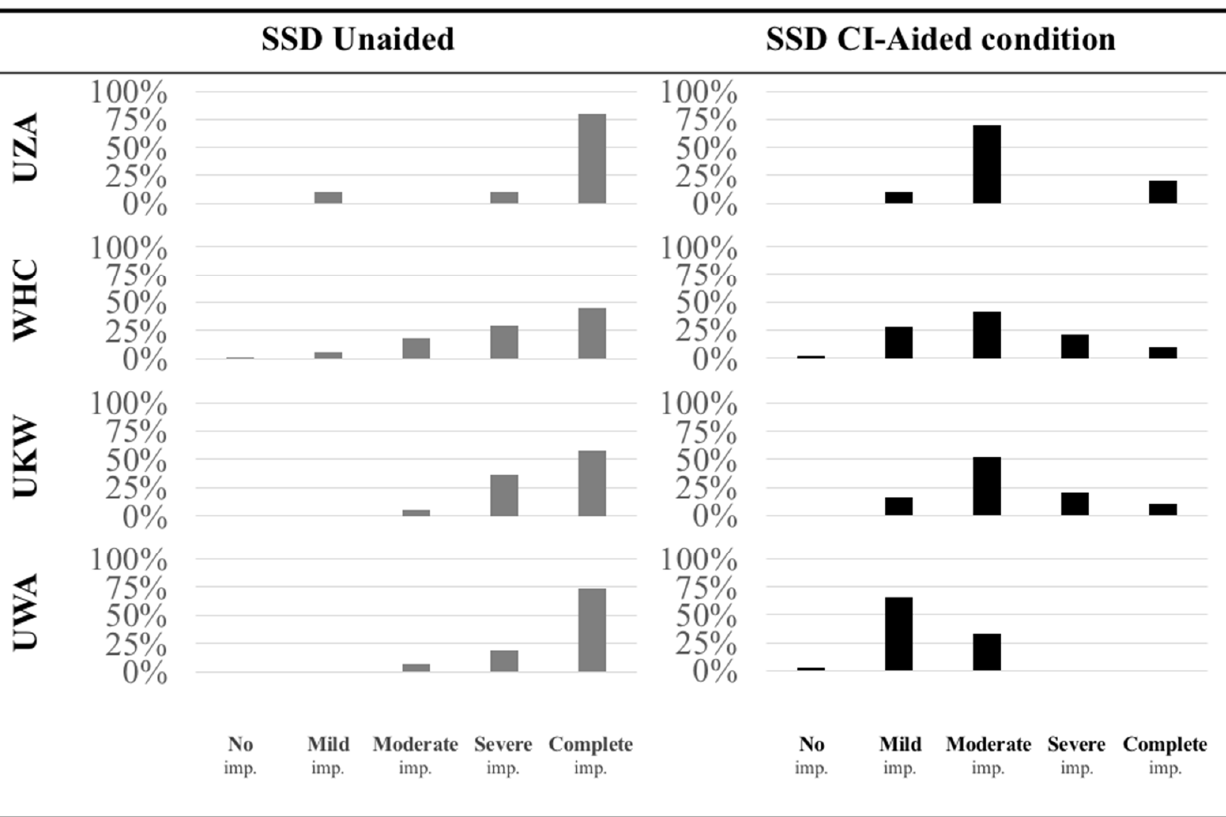
Figure 3. Application of the HEARRING_LOC_ICF scale on SSD CI data from the Antwerp University Hospital (UZA) in Belgium, for the World Hearing Center (WHC) in Poland, for the University Clinic of Würzburg (UKW) in Germany, and for the University of Western Australia (UWA) in Australia. Histograms are presented with the distribution of the observed localization impairments in the unaided and the CI-aided conditions.